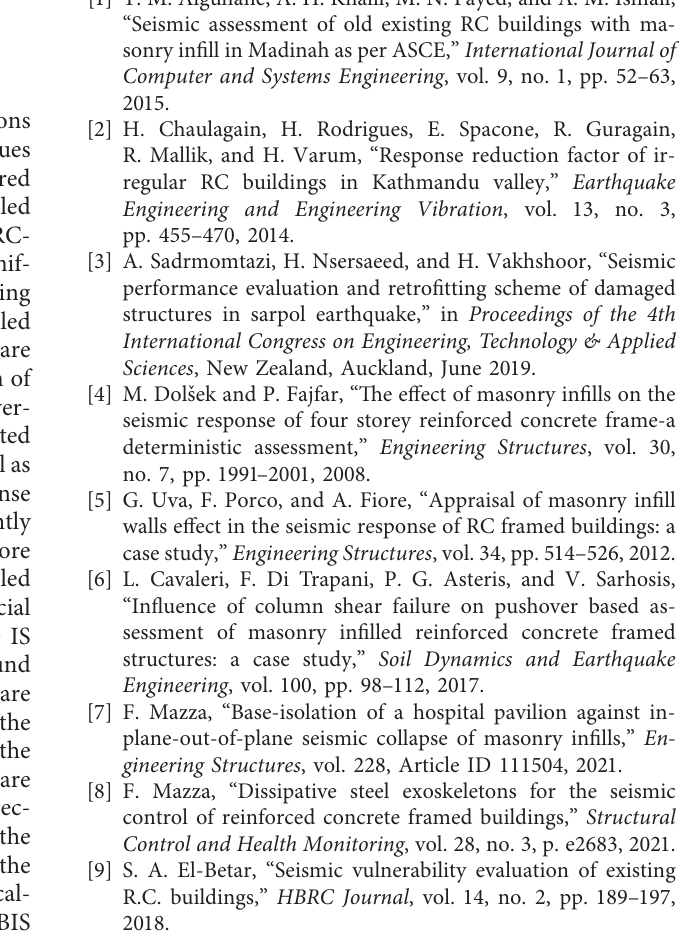
Figure 19: Graph of average R -factor versus structural plan density